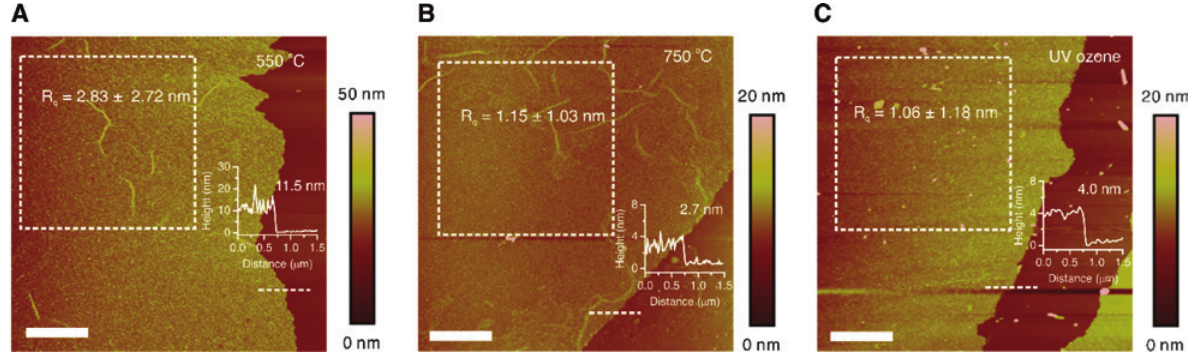
Figure 3: AFM traces of hBN after post-transfer processing. The results in (A) and (B) were collected from samples after annealing at 550 and 750 ° C, respectively. Scale bar: 2 μ m. The results in (C) were obtained from a sample after UV ozone cleaning. Scale bar: 2 μ m. Dashed lines on the sample edge indicate where the height profiles were collected, while the dashed box defines the area where the roughness values were